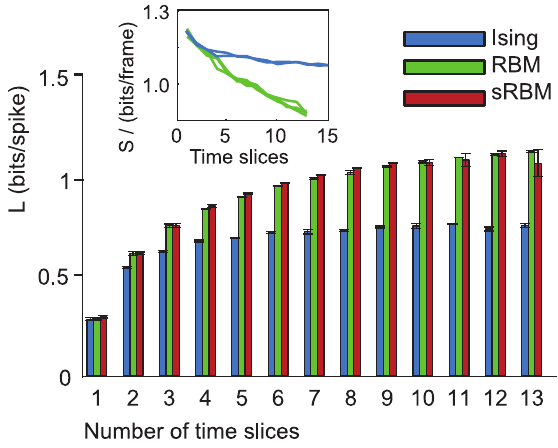
Figure 5. Likelihood comparison as a function of model size. Spatiotemporal models with 10 cells and a varying number of concatenated time steps. The log-likelihood per spike increases as each neuron is modeled as part of a longer time sequence. This effect holds both for Ising and higher-order models. Since the Ising model cannot capture many of the relevant dependencies, the increase in likelihood saturates after about 3 timesteps for the Ising model, but continues to increase for the higher-order models. Insert: Comparison of the entropy per time slice for Ising and RBM models as a function of model size. As the RBM is better able to model spatiotemporal dependencies, the additional entropy for extra frames is smaller than for the Ising models. The RBM does not reach the point of extensivity, where additional frames add constant entropy. Multiple lines of the same color indicate repeated runs with different random